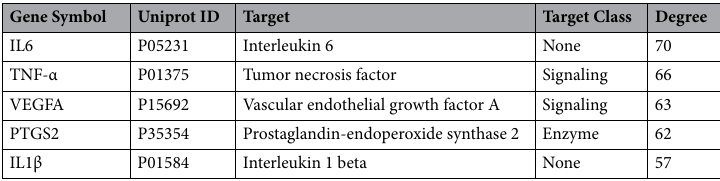
Table 2. Hub genes and topological